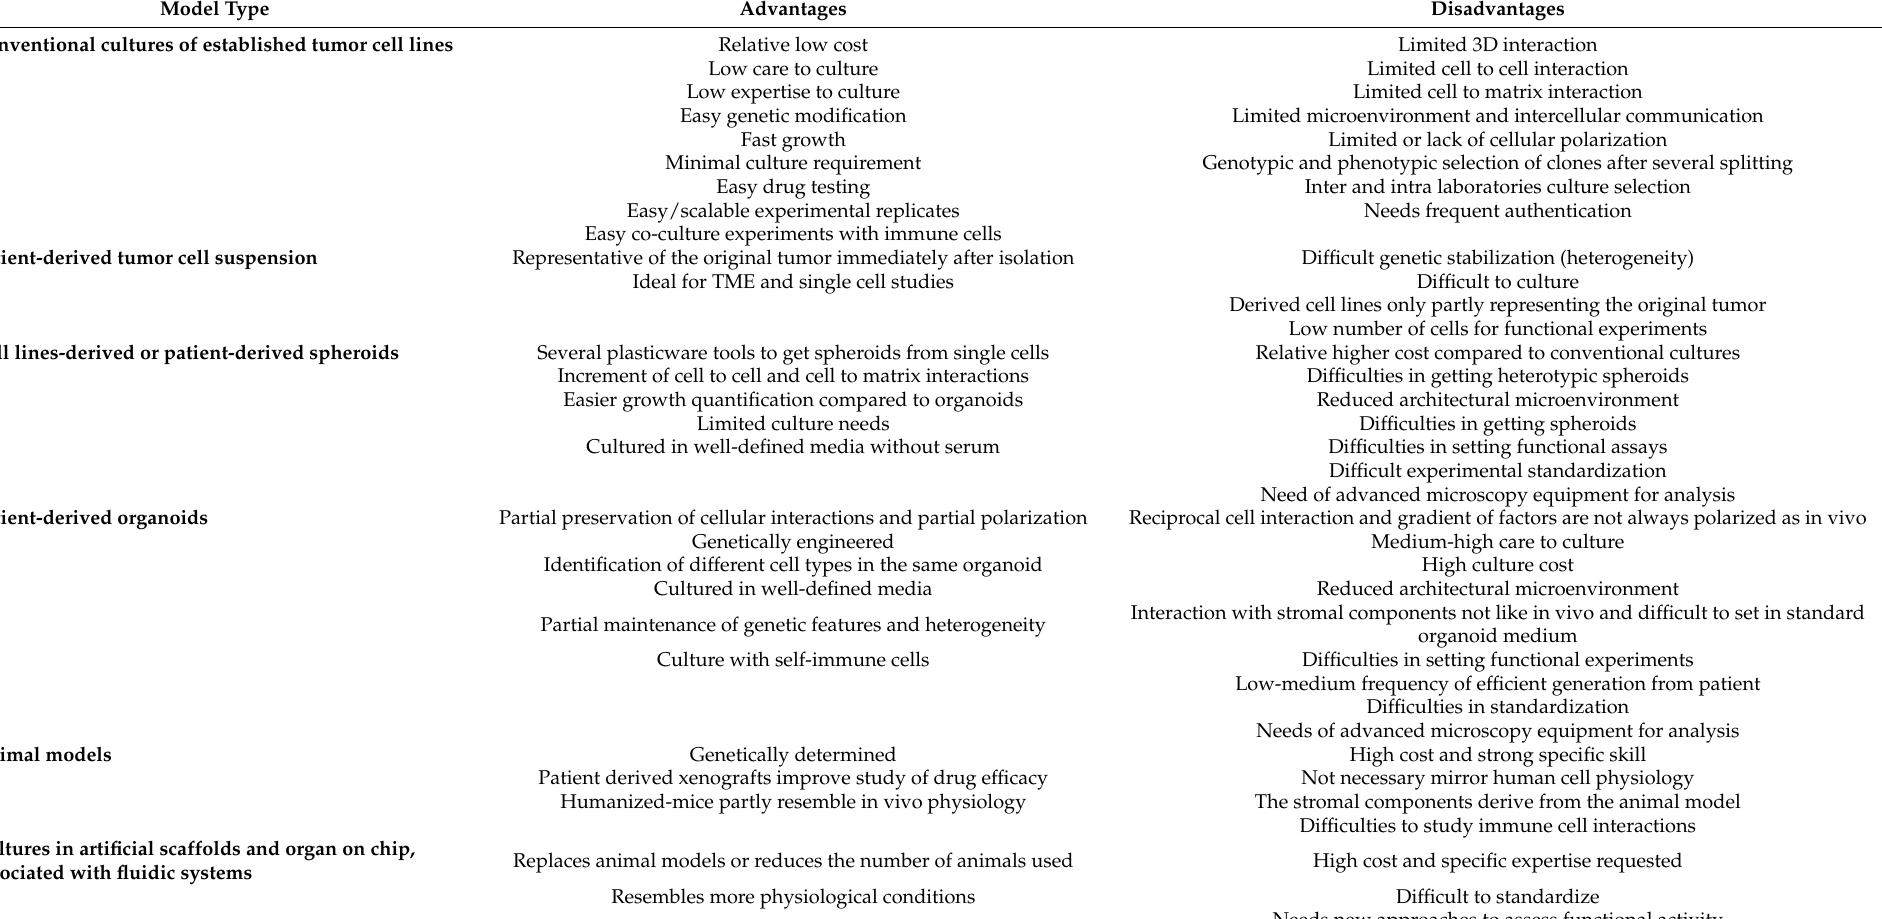
Table 1. Advantages and disadvantages of in vitro and in vivo tumor cell culture models to study interactions with immune